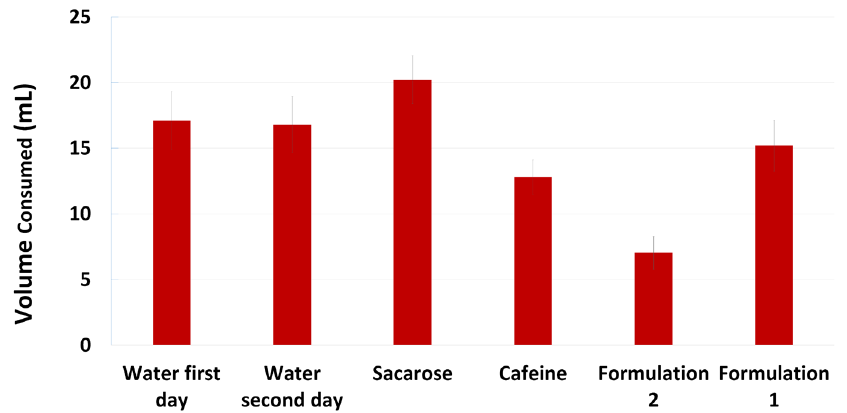
Figure 7 - Results of the in vivo palatability test in rats. The values are mean S.D. of 6 determinations.